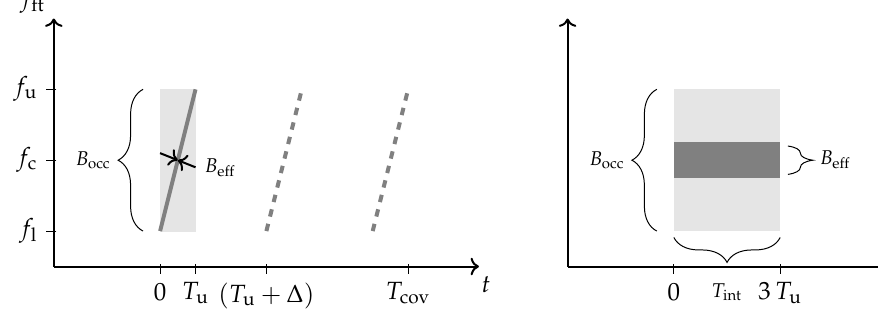
Figure 2. Occupied bandwidth B occ ≈ f u − f l vs. effective instantaneous bandwidth B eff of an exemplary LFM waveform that is measurable before chirping or after dechirp-on-receive